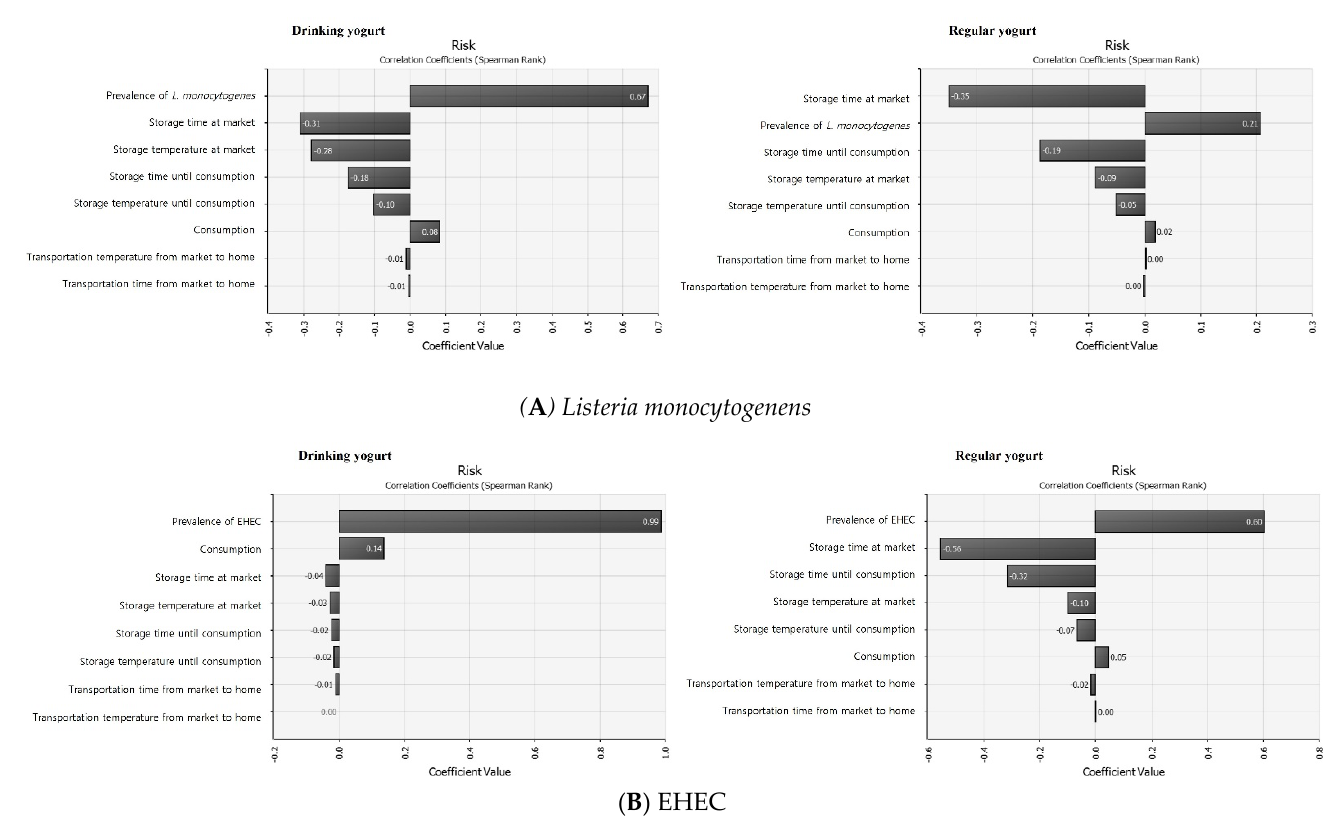
Figure 5. The correlation coefficient for sensitivity analysis affecting illness by Listeria monocytogenes ( A ) and EHEC ( B ) with consumption of yogurt with @Risk.